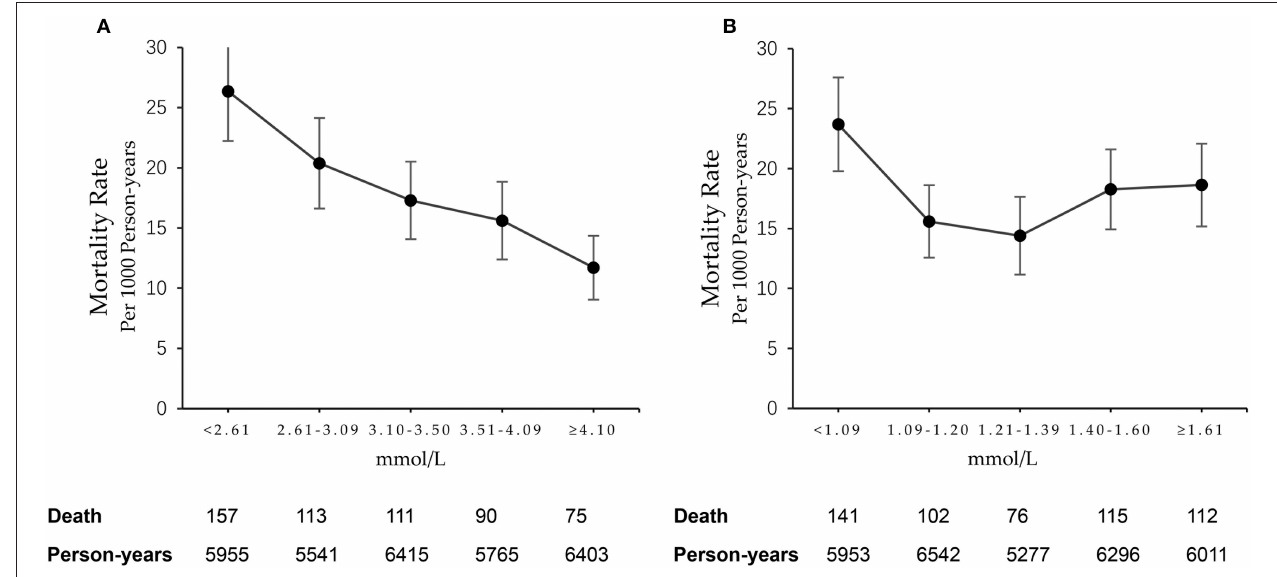
FIGURE 1 | Mortality rates in subgroups according to quintiles of (A) LDL-C and (B)